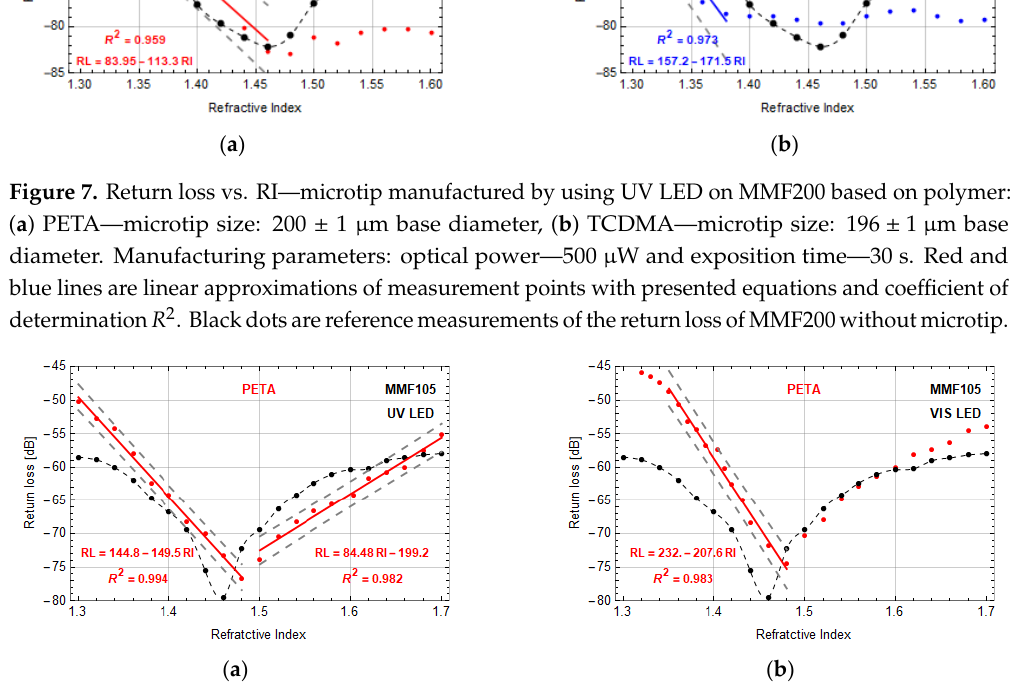
Figure 8. Return loss vs. RI—microtip manufactured on MMF105 based on PETA monomer by using: ( a ) UV LED, optical power 10 µW (microtip size: 84 ± 1 µm base diameter), ( b ) VIS LED, optical power 30 µW (microtip size: 105 ± 1 µm base diameter). Manufacturing parameter: exposition time—30 s. Red lines are linear approximations of measurement points with presented equations and coefficient of determination R 2 . Black dots are reference measurements of the return loss of MMF105 without microtip.